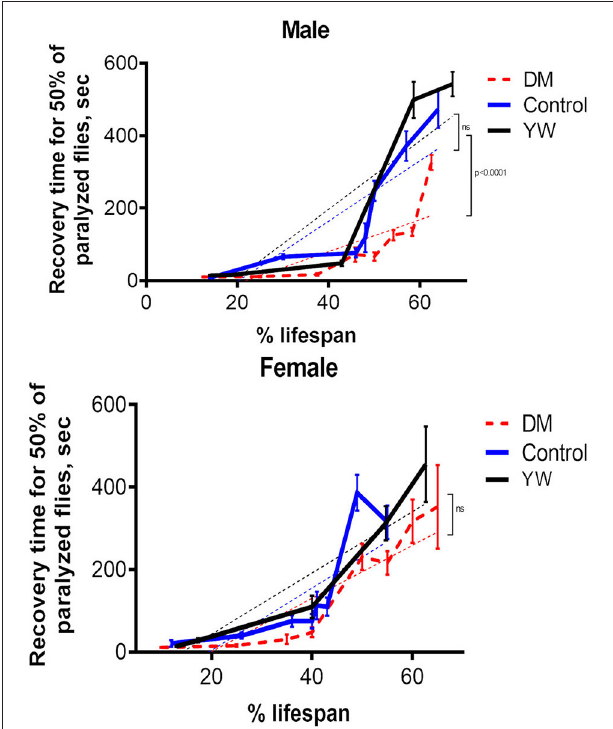
FIGURE 5 | Acquired temperature sensitive paralysis. Measurements were done in the DM, control (Da-GAL4, dprx5 / + ), and y w flies at different ages ( Supplementary Table 4 ). Results are means ± SEM normalized to percent of life span. The dotted lines represent linear regression analysis curves. There were no statistically significant differences in age-specific changes in recovery time for 50% of paralyzed female flies between the DM and control lines, as determined by analysis of the slopes of corresponding regression lines. Statistically significant differences were observed between the DM and control male flies ( P < 0.0001). There were no significant differences between driver control ( + /Da-GAL4 , dprx5 ) and y w